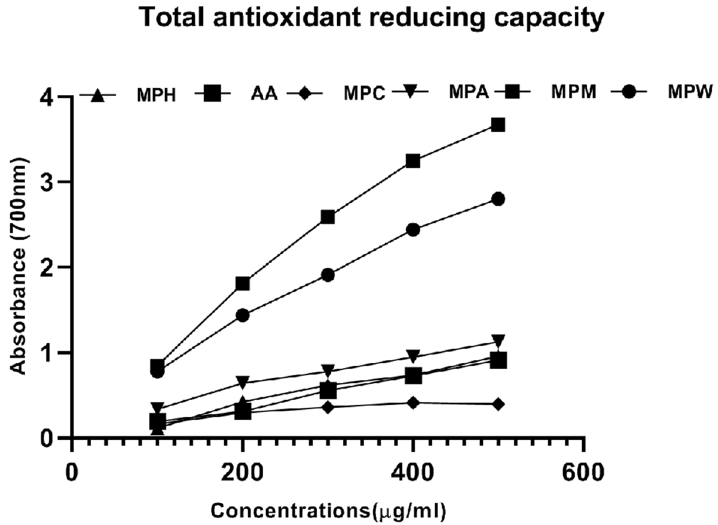
Figure 1. Total antioxidant reducing capacity of different concentrations of M. paniculata leaf extracts by reducing power assay. MPH: M. paniculata Hexane, MPA: M. paniculata Acetone, MPM: M. paniculata